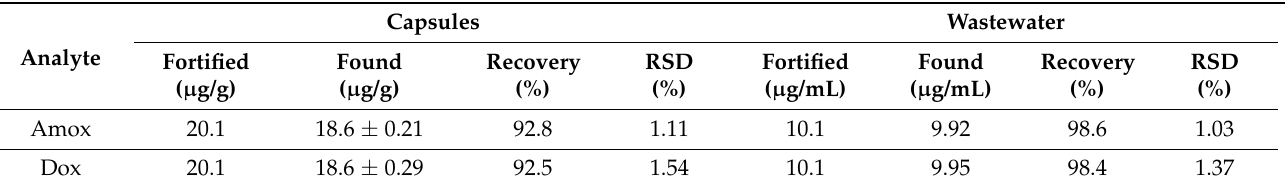
Table 3. Results of